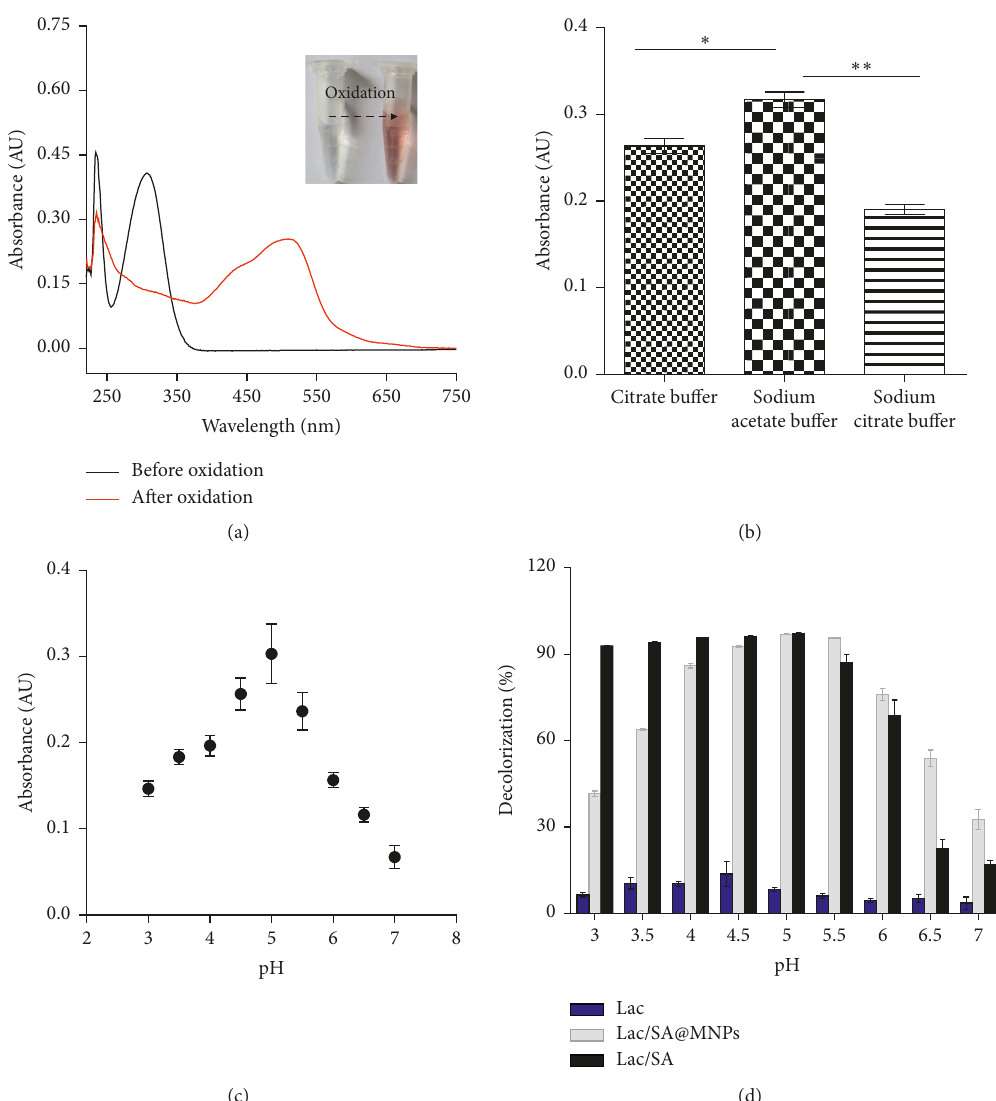
Figure 7: (a) UV-Vis spectra of SA before and after oxidation by Lac. (b) Effects of buffer type on SA oxidation by Lac. (c) Effects of pH on SA oxidation by Lac. (d) Effects of pH on dye decolorization by Lac, Lac/SA@MNPs, and